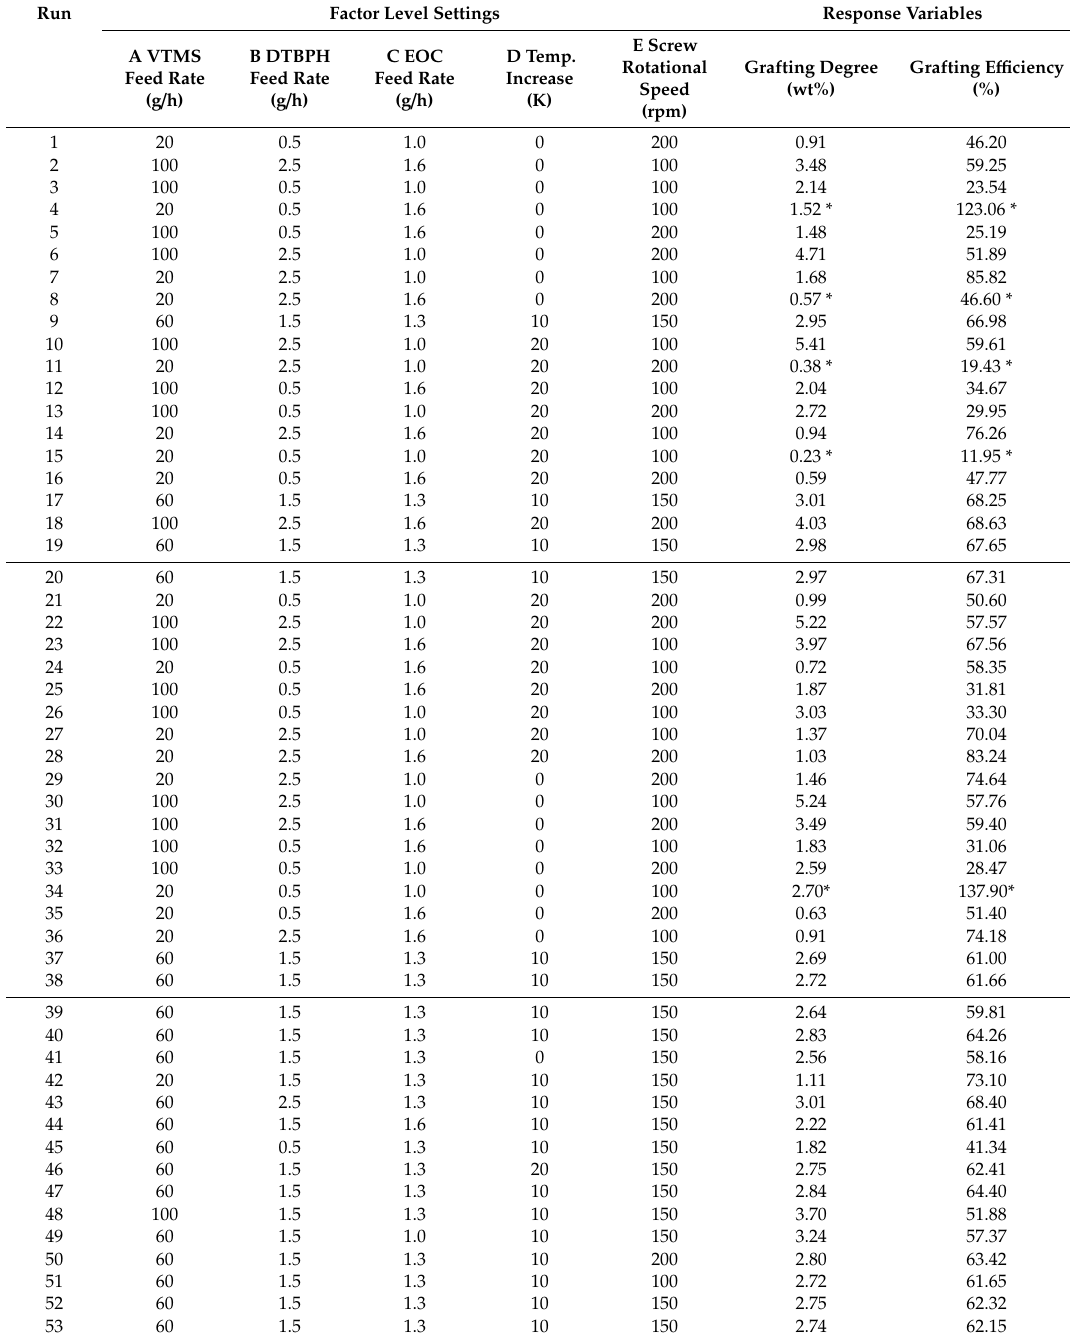
Table 3. Experimental data for response surface analysis of the face-centered experimental design with three-level factor settings for the five factors. The experiments are shown in the randomized order the runs were actually performed. Experiments were conducted in three blocks: Block 1: Runs 1 to